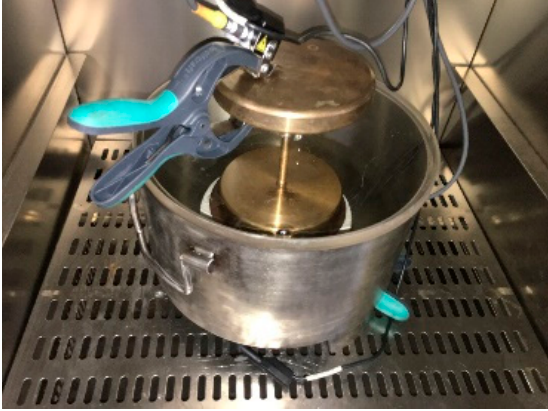
Figure 2. Three-electrode test device.